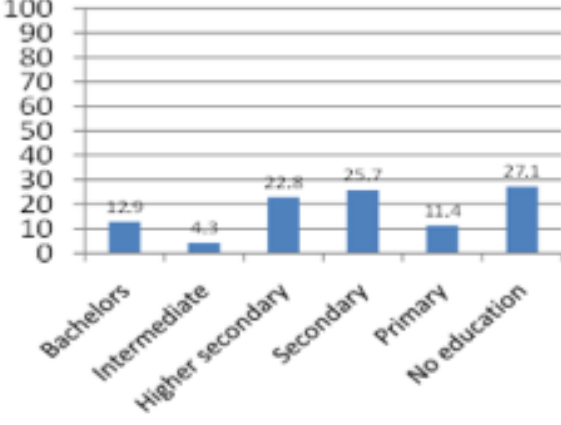
Figure 2: Bar diagram showing education level of the